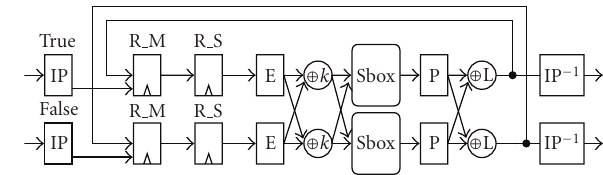
Figure 3: Part of our WDDL 3DES cryptoprocessor processing the 32-bit block